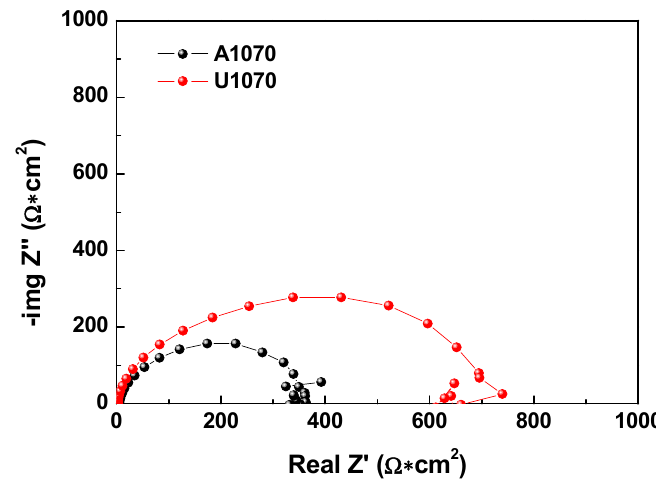
Figure 6. Nyquist plot of A1070 and U 1070 in a salt water–acetic acid solution at 47 °C.